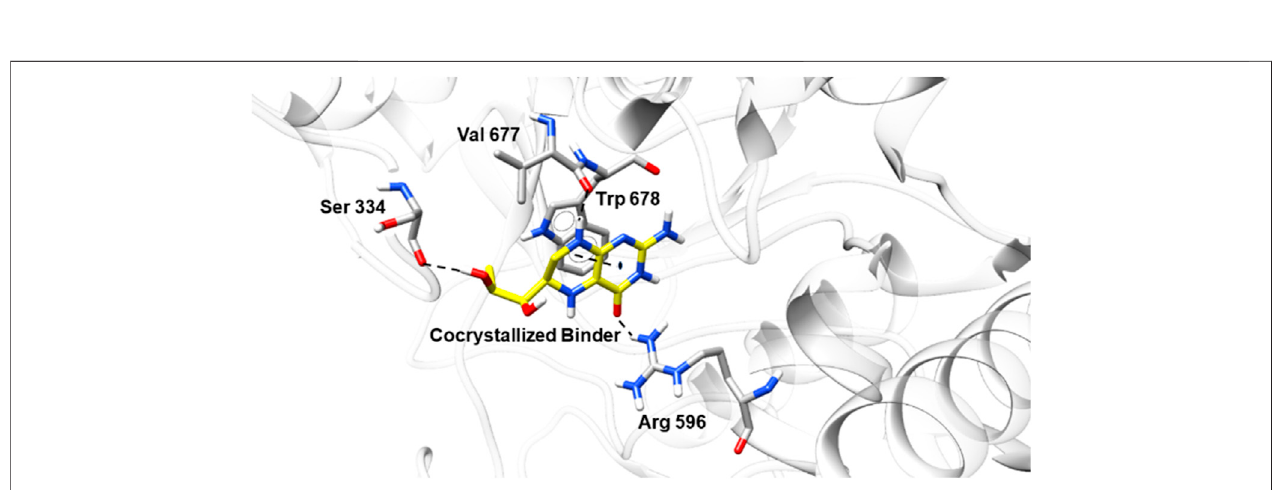
FIGURE 8 | Conformation of the crystallographic ligand in the binding site of NO synthase (PDB ID 6NGJ) after the redocking studies.